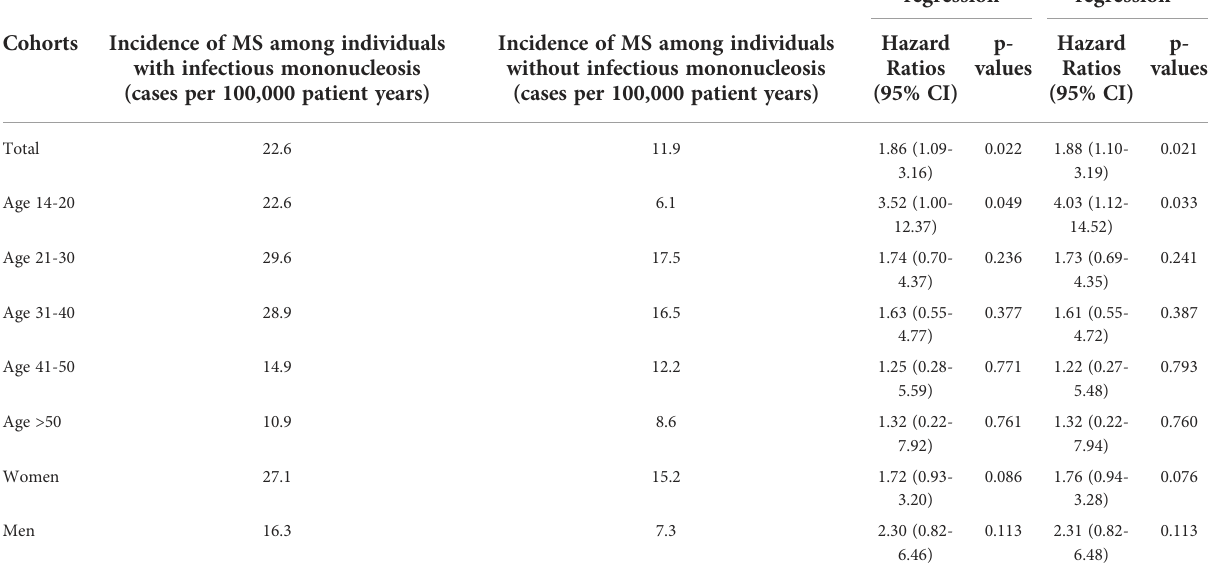
TABLE 2 Association between infectious mononucleosis and the subsequent incident multiple sclerosis diagnosis in patients followed in general practices in Germany (Cox regression